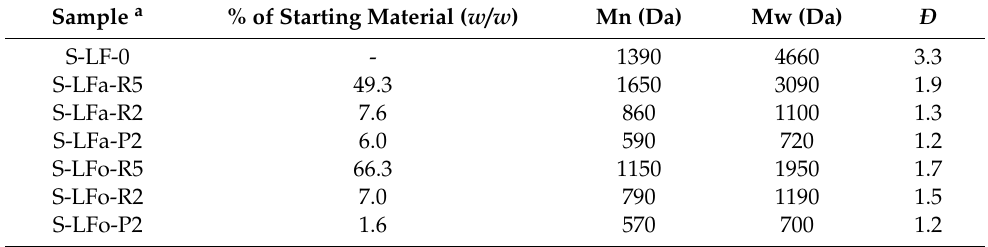
Table 1. GPC analysis (molecular weights Mn and Mw, polydispersity index Ð of all examined soluble lignin fractions from S-LF-0 obtained with the two fractionation methods).